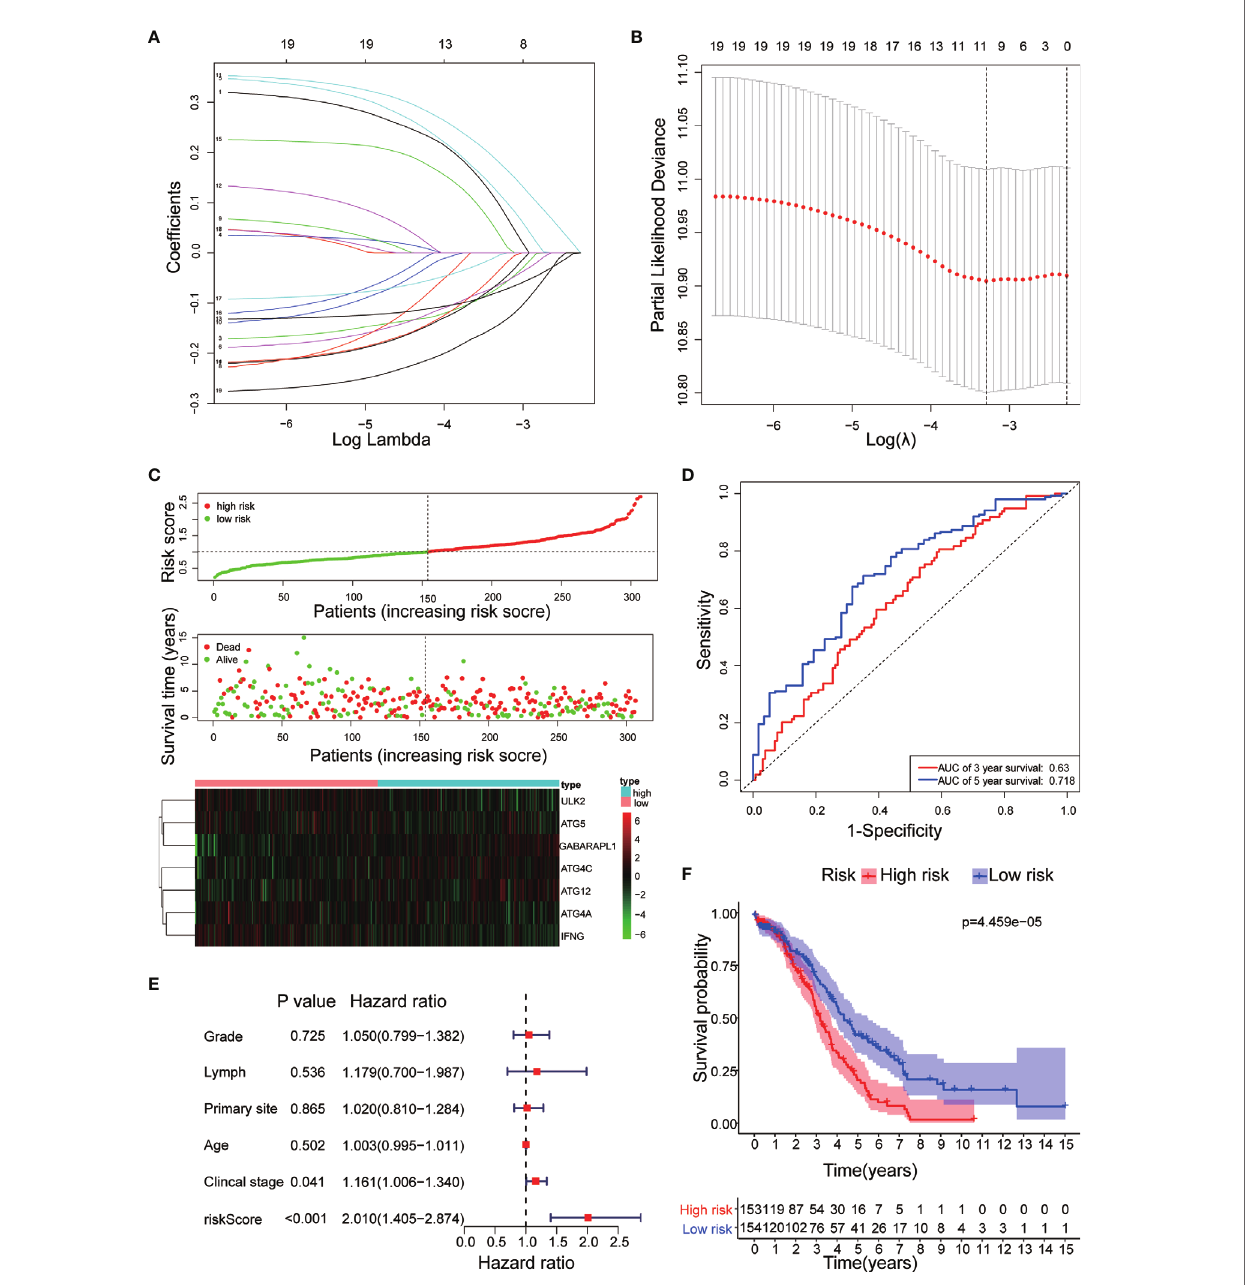
FIGURE 5 | Construction of the ARG prognostic classi fi er. (A, B) Determination of the number of factors by LASSO analysis. (C) The distribution of risk score, survival duration and status of patients and a heatmap of the ARGs in the classi fi er. (D) The signature was evaluated by using the sensitivity and speci fi city of the ROC curve. (E) Univariate Cox proportional hazards regression analysis and the correlation between the risk score, age, grade, lymphovascular invasion indicator, primary site and clinical stage. (F) Kaplan-Meier analysis of TCGA OC patients strati fi ed by median risk